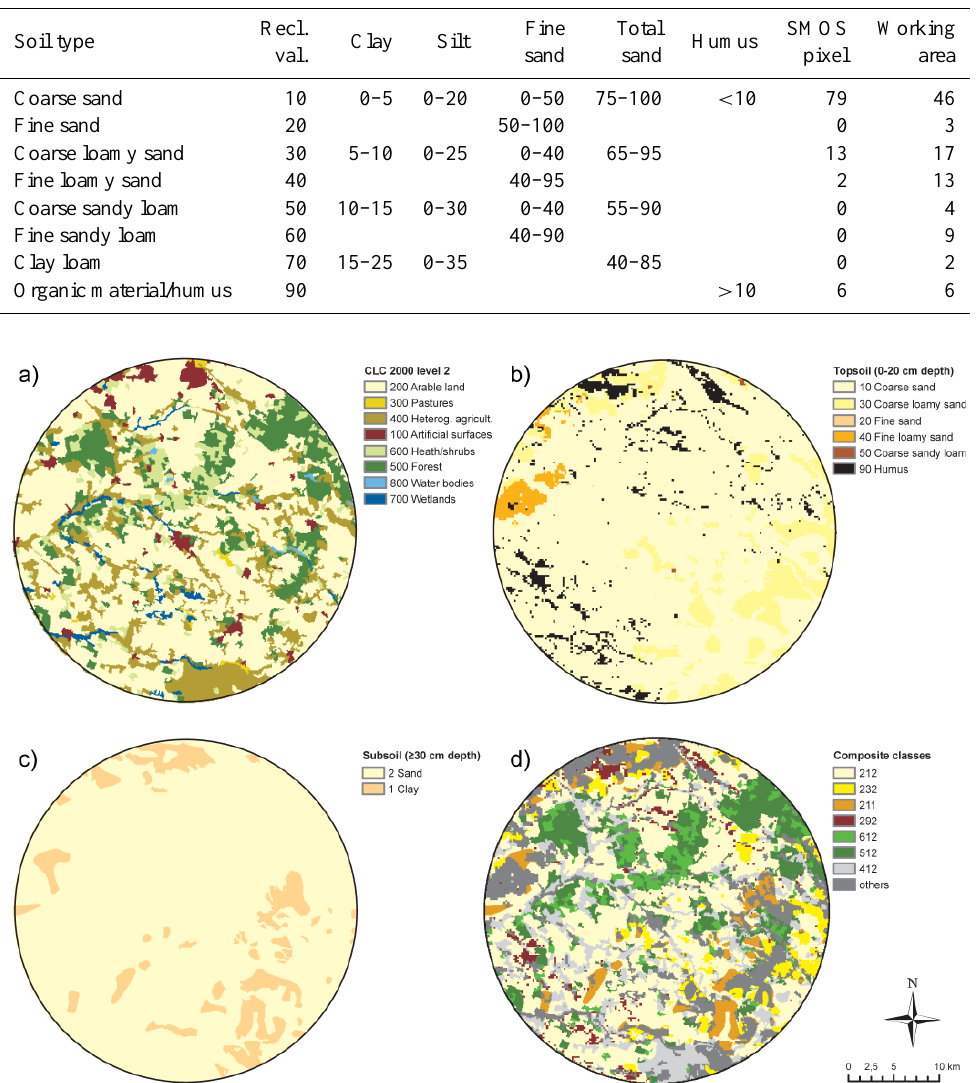
Fig. 3. Land cover type (a) , topsoil types (b) , subsoil types (c) and composite classes, combining land cover type, topsoil and subsoil types (d) within the selected SMOS pixel around SMOS Discrete Global Grid node